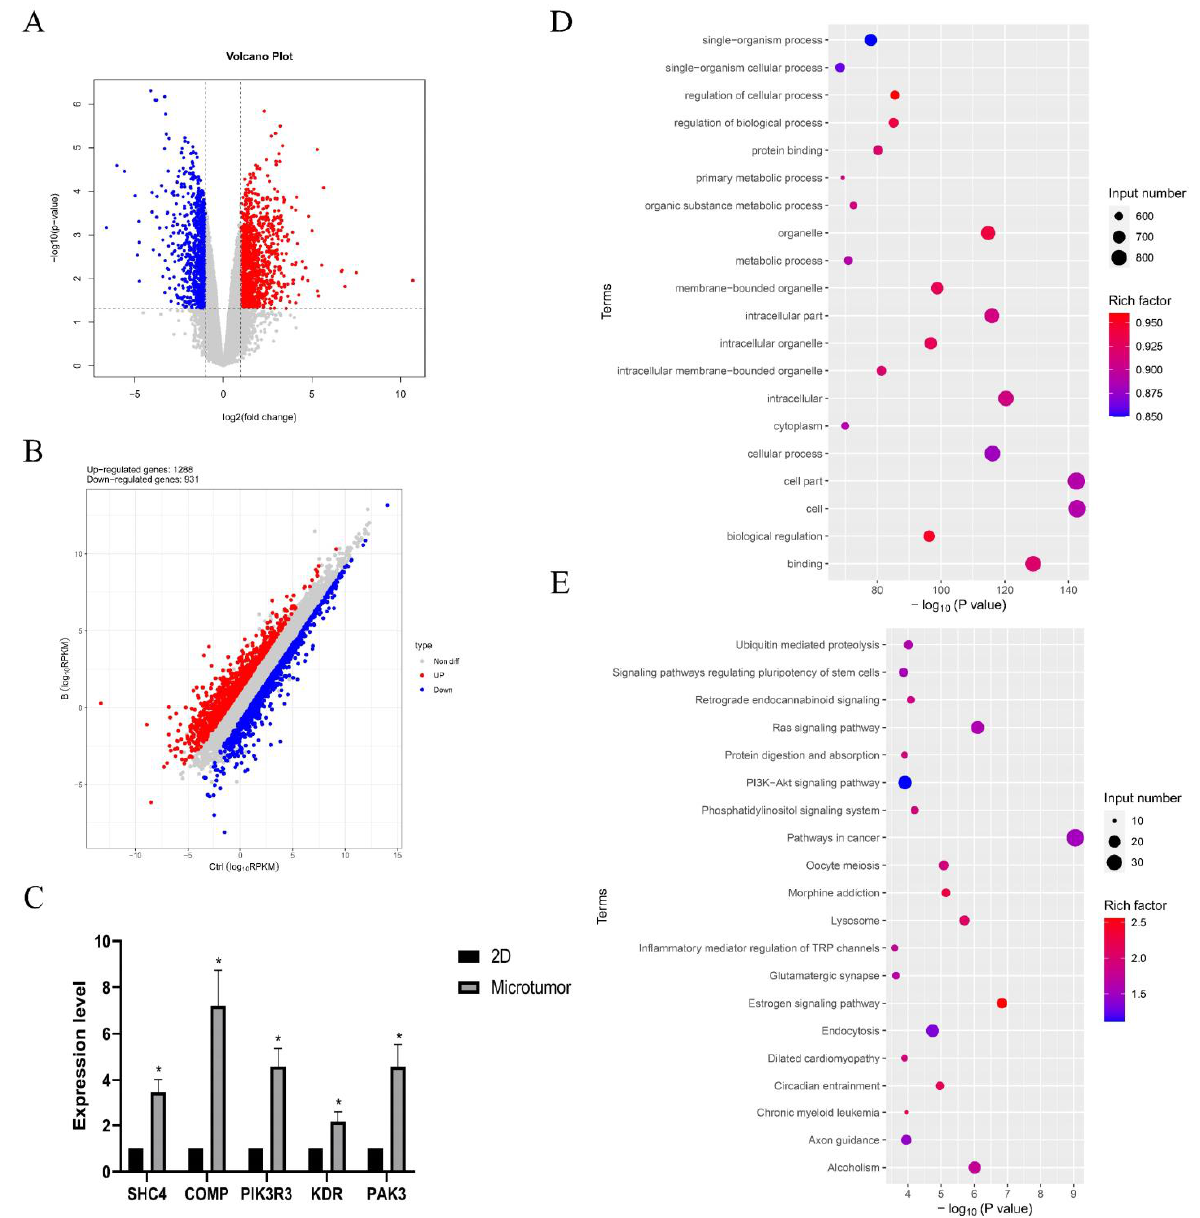
Figure 5. Results of the RNA sequencing. ( A ) Volcano plot; ( B ) the differential expressions of genes between the CD31+ HemEC microtumors and the 2D cell model. High relative expression is indicated by red, whereas low relative expression is indicated by blue. ( C ) Gene expression levels of focal adhesion-related genes (SHC4, COMP, PIK3R3, KDR, and PAK3). ( D , E ) The top 20 enriched GO and KEGG signaling pathways for significantly upregulated genes. * p < 0.05 compared to the 2D culture.